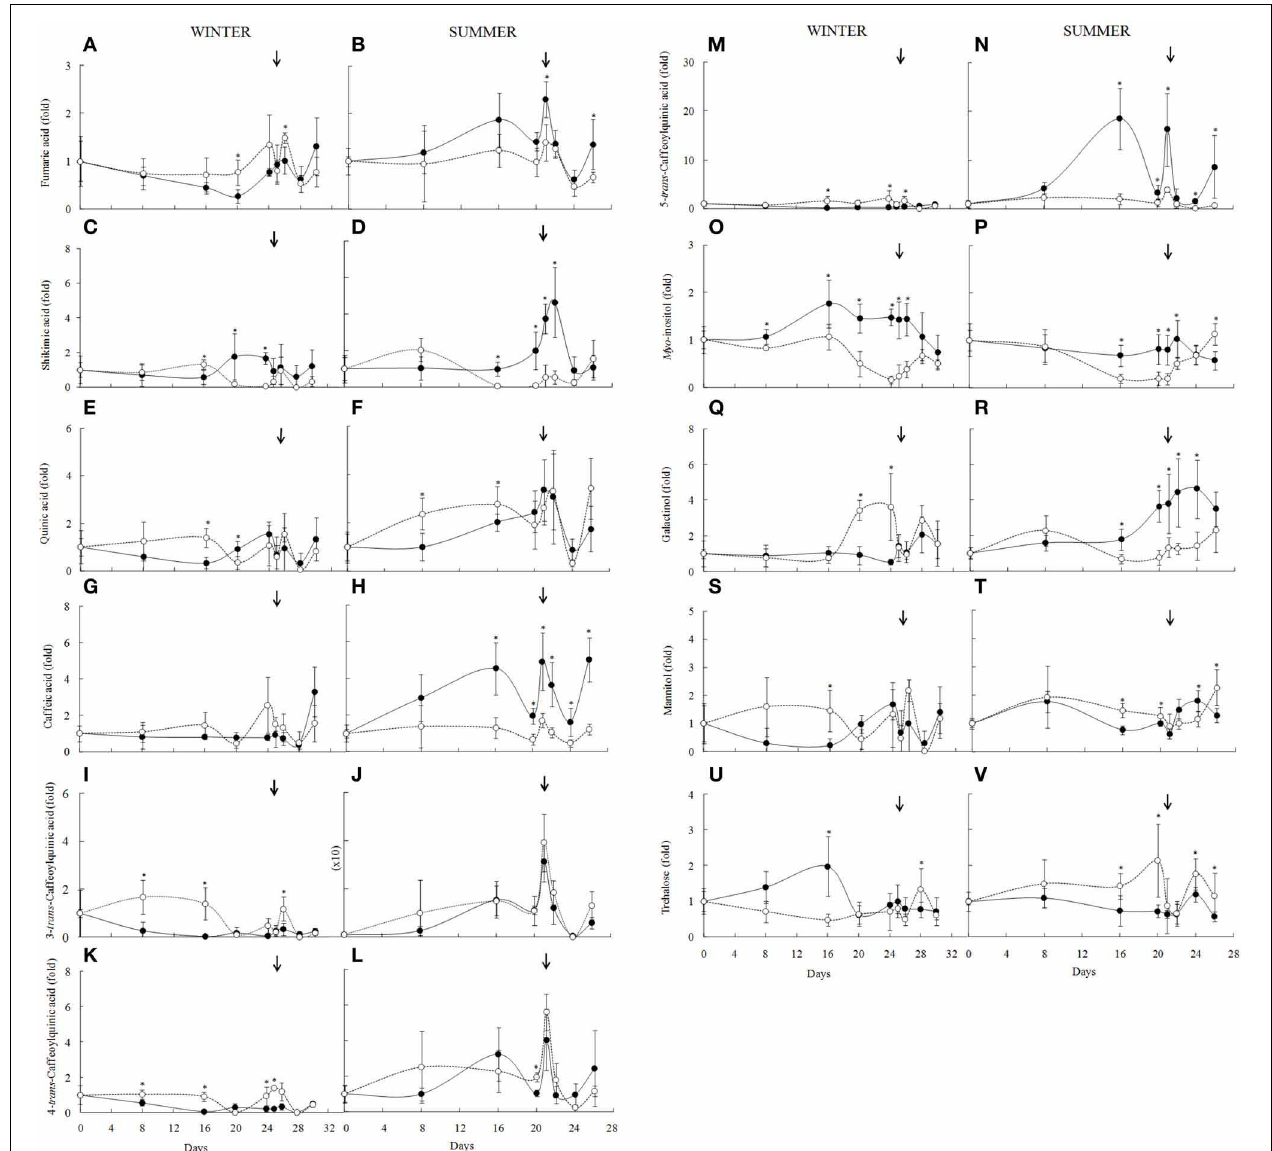
FIGURE 5 | Metabolite profile of the Barbacenia purpurea leaves during dehydration and rehydration. Organics acids (A–N) , polyols (O–T) , trehalose (U,V) in leaves of daily watered plants (control group— • ) and plants under water suppression (treatment group— ◦ ) in winter (left side)